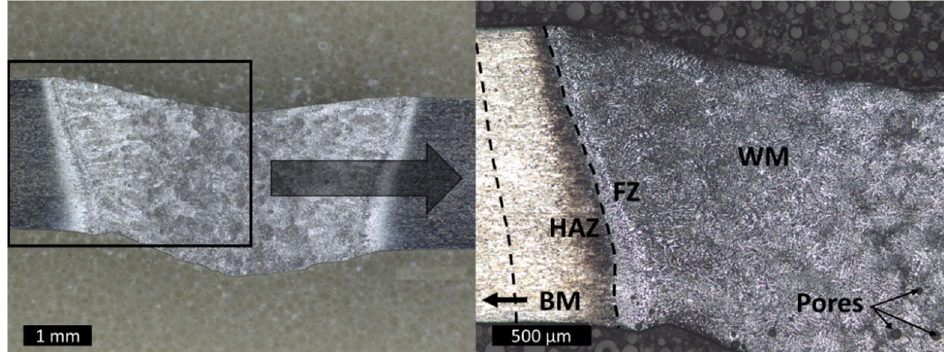
Figure 7. Optical microscope (OM) image of a welding seam (standard parameters—without heat treatment).